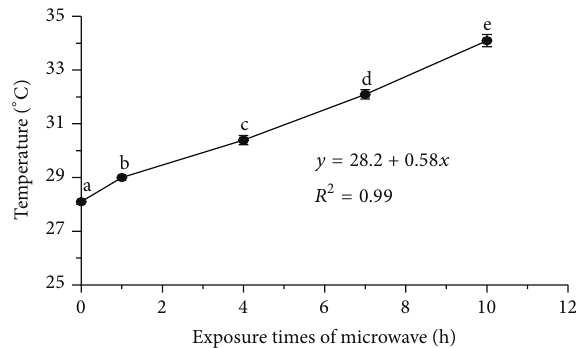
Figure 2: The effects of different exposure times of microwave fre- quency on primary shoot and root length in MR 219 rice seedlings. Figure 3: The effect of exposure times of microwave frequency on thewater’stemperaturearoundtheseedsinsidethePetridishes.Ver- ticalbarsrepresentthestandarderrorofmeanforthreesamples,and values superscripted by different letters are significantly different by Duncan’s multiple range test ( 𝑃 ≤ 0.01